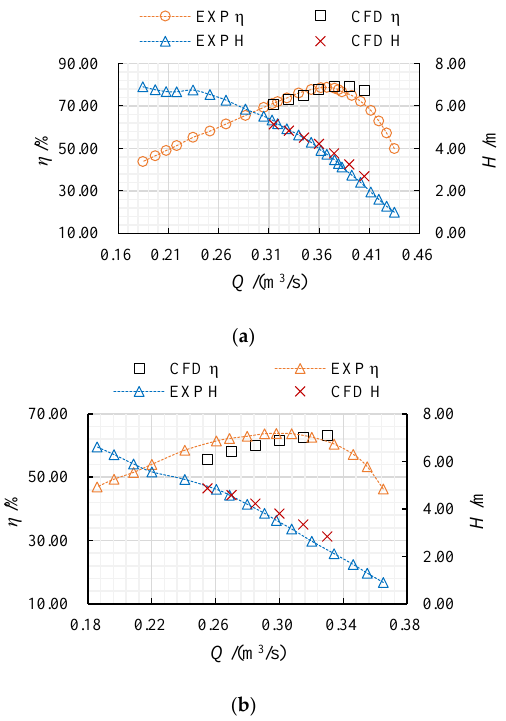
Figure 19. The comparison of pump performance between the simulated data and experiment data under the ( a ) forward operation and ( b ) reverse operation. Table 9. The main design parameters of the optimized reversible axial-flow pump.